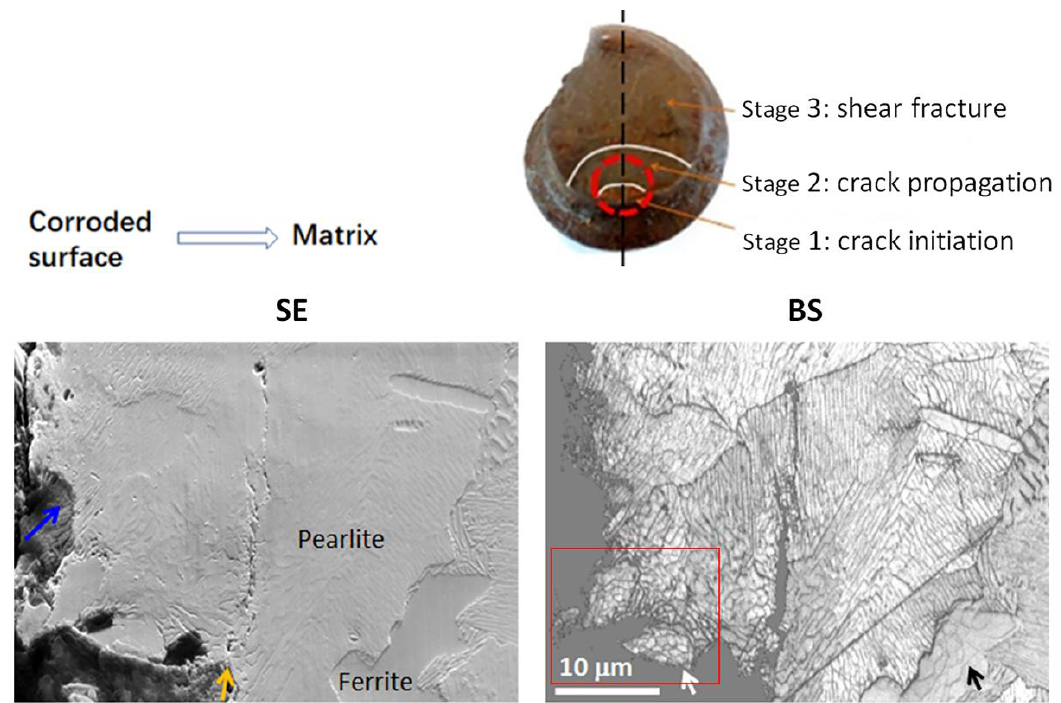
Figure 2. OM micrograph (top) to show the fracture surface while SEM secondary electron (SE) and EBSD BS maps show the same sub-surface area in the cross-section. The dark-grey area in the BS map represents the un-indexed zone due to oxidation and cracks.